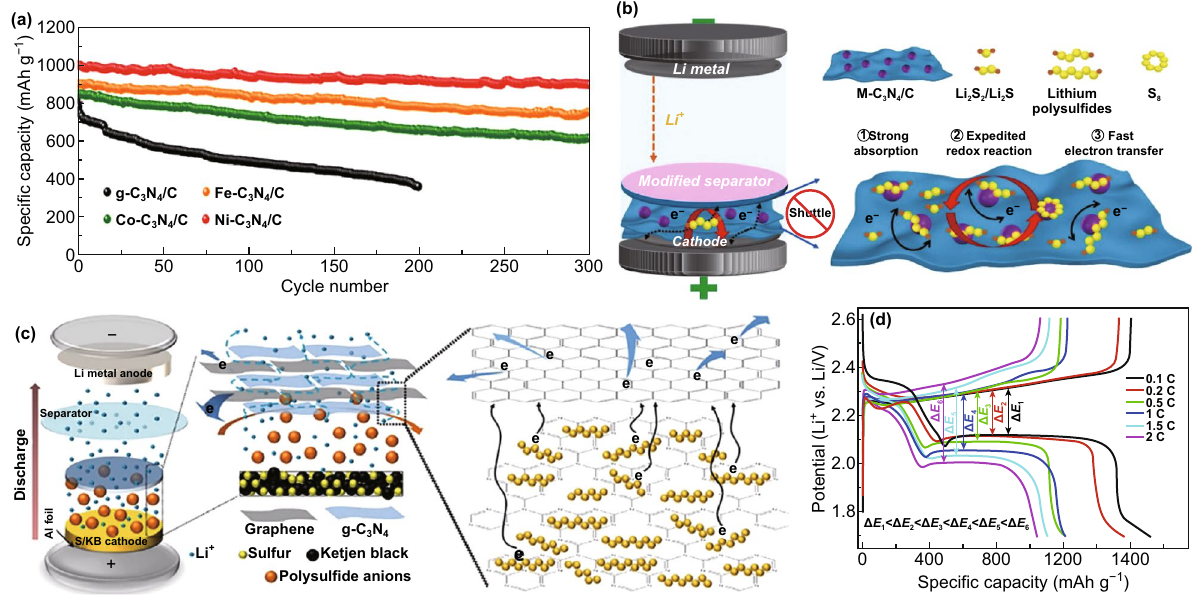
Fig. 23 a Cycling performance of the heteroatom-doped-C 3 N 4 /C-modified separators at 0.5 A g −1 . b Schematic illustration of the M-C 3 N 4 /C- modified separator to suppress the shuttle of polysulfides and expedite conversion reaction kinetics of polysulfides. Reproduced with permission from Ref. [69]. c Schematic of cell configuration with a laminated structure g-C 3 N 4 /GS cathode interlayer. d Charge/discharge profiles for the S/KB@C 3 N 4 /GS cathode at various scan rates. Reproduced with permission from Ref. [137]. Copyright permissions from Elsevier and Wiley– VCH. (Color figure